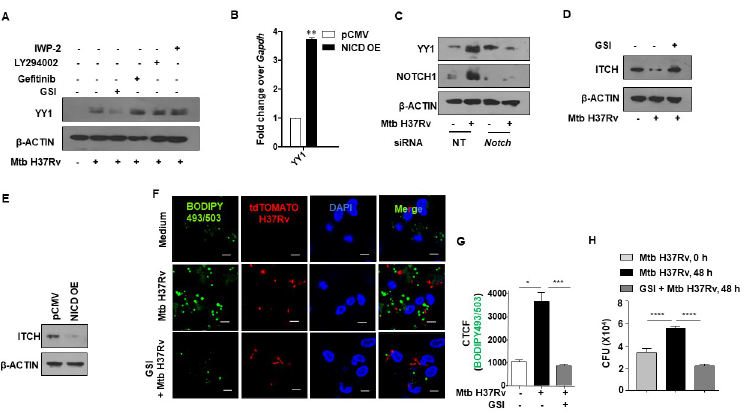
Fig 3. Activated NOTCH signaling pathway aids in enhanced YY1 expression during Mtb infection. (A) Mouse peritoneal macrophages were treated with the indicated inhibitors for 1 h, followed by 24 h infection with Mtb H37Rv. Whole cell lysates were assessed for the expression of YY1 by immunoblotting. (B) RAW 264.7 cells were transfected with pCMV or NICD overexpression vectors and assessed for the transcript levels of Yy1 by qRT-PCR. (C) Mouse peritoneal macrophages were transfected with NT or Notch siRNAs. Transfected cells were infected with Mtb H37Rv for 24 h and assessed for the expression of YY1 and NOTCH1 by immunoblotting. (D) Mouse peritoneal macrophages were treated with NOTCH pathway inhibitor GSI for 1 h, followed by 24 h infection with Mtb H37Rv. Whole cell lysates were assessed for the expression of ITCH by immunoblotting. (E) RAW 264.7 cells were transfected with pCMV control or NICD overexpression vectors and assessed for the expression of ITCH by immunoblotting. (F, G) Mouse peritoneal macrophages were treated with the NOTCH pathway inhibitor GSI for 1 h, followed by 48 h infection with tdTomato Mtb H37Rv and analyzed for lipid accumulation (BODIPY493/503) by confocal microscopy; (F) representative image and (G) respective quantification. (H) Mouse peritoneal macrophages were infected with Mtb H37Rv for 4 h. Extracellular bacteria were removed, and the infected cells were cultured in the presence or absence of PRMT5 inhibitor, EPZ015666 for 48 h. Cells were lysed and plated on 7H11 to enumerate intracellular Mtb H37Rv burden. qRT-PCR data represents mean ± S.E.M. and immunoblotting and immunofluorescence data are representative of three independent experiments. OE, over expression; NT, non-targeting; CTCF, corrected total cell fluorescence; CFU, colony forming units. IWP-2, WNT pathway inhibitor; LY294002, PI3K pathway inhibitor; Gefitinib, EGFR pathway inhibitor; GSI, Gamma secretase inhibitor (GSI), NOTCH pathway inhibitor. � , p < 0.05; �� , p < 0.01; ��� p < 0.001; ���� , p < 0.0001 (Student’s t-test in D, One way ANOVA in G,H; GraphPad Prism 6.0). Scale bar, 5 μ